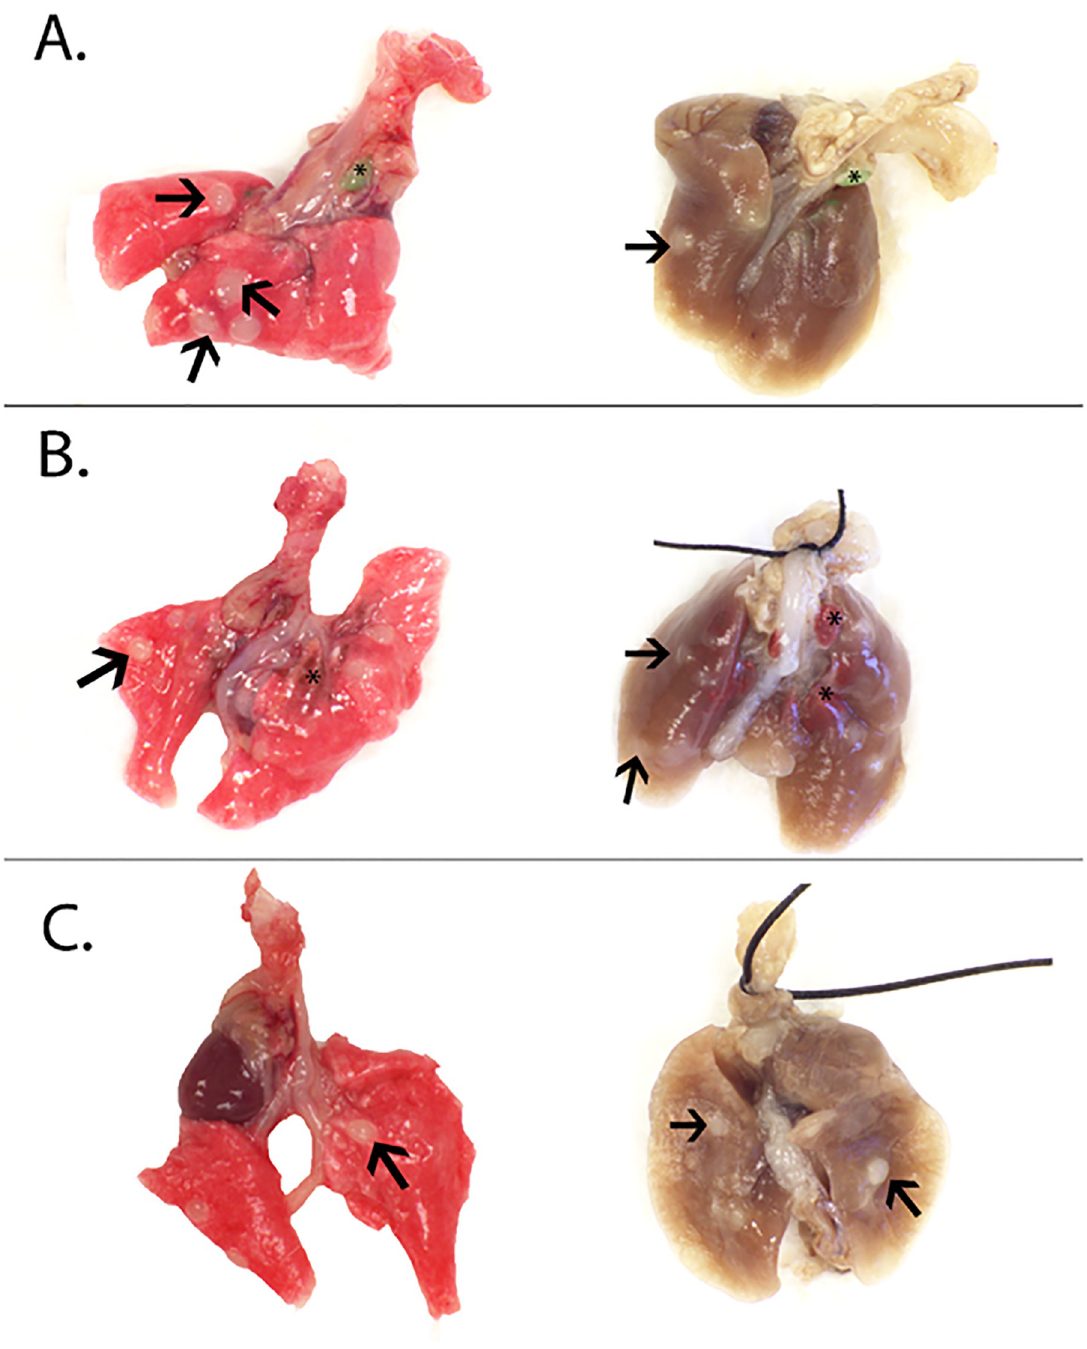
Fig 9. Lung tumors pre-fixation (left) and 24 hours post-fixation (right) following exposure to NiO (panel A), Cr 2 O 3 + CaCrO 4 (panel B), and Fe 2 O 3 (panel C). Tumors (arrows) were on average ~1 mm in diameter and opaque in color.